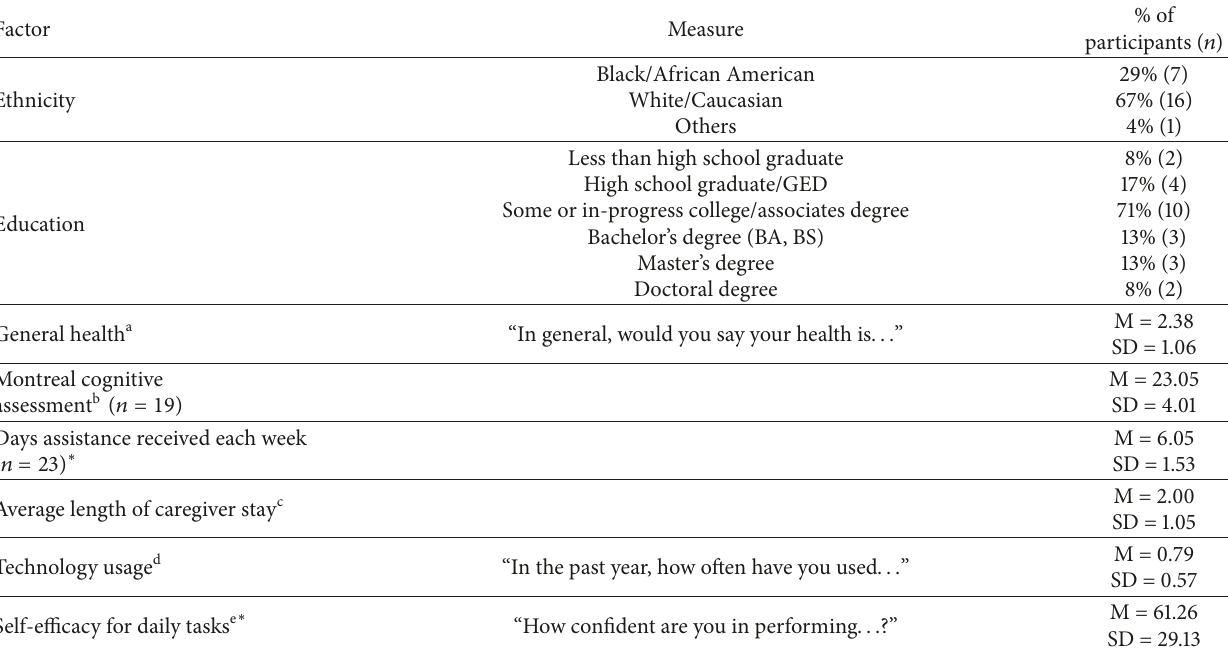
Table 1: Participant characteristics.